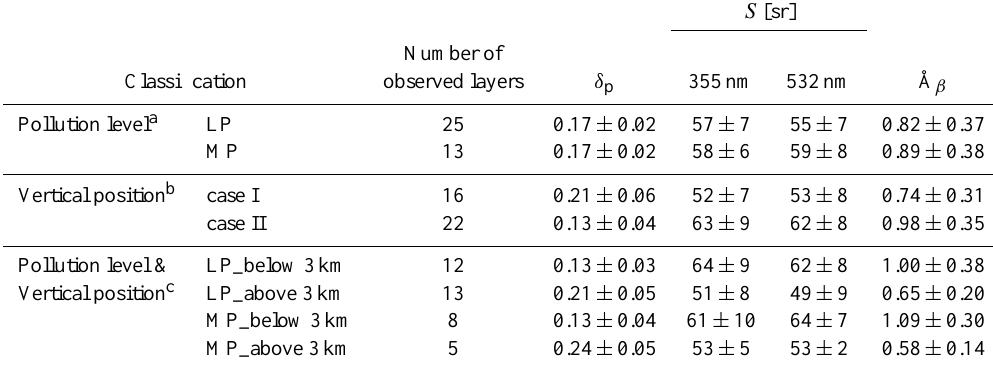
Table 1. Summary of the linear particle depolarization ratio at 532nm, lidar ratios, and backscatter-related Ångström exponents of Asian dust layers for each classification. Asian dust layers were classified according to a levels of anthropogenic pollution emissions: LP denotes that Asian dust layers which are considered less polluted and MP denotes that Asian dust layers which are considered more polluted; b their vertical position in a polluted region: case I indicates Asian dust layers passed over China at high altitude ( > 3km) before they arrived over Gwangju, and case II indicates Asian dust layers were transported at low altitude ( < 3km) over industrialized areas before they arrived over Gwangju; and c their vertical position (below 3km or above 3km) and level of pollution (LP or MP) when they passed over